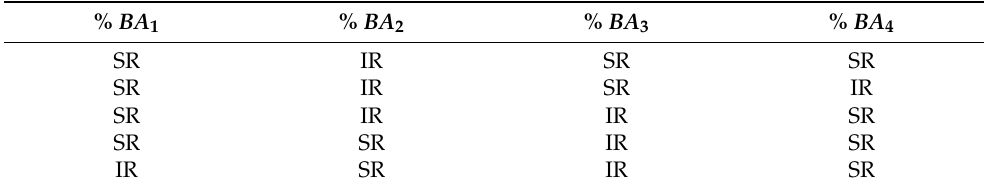
Table 2. Five cases for stratified plots (SR: Sufficiently represented; IR: Insufficiently